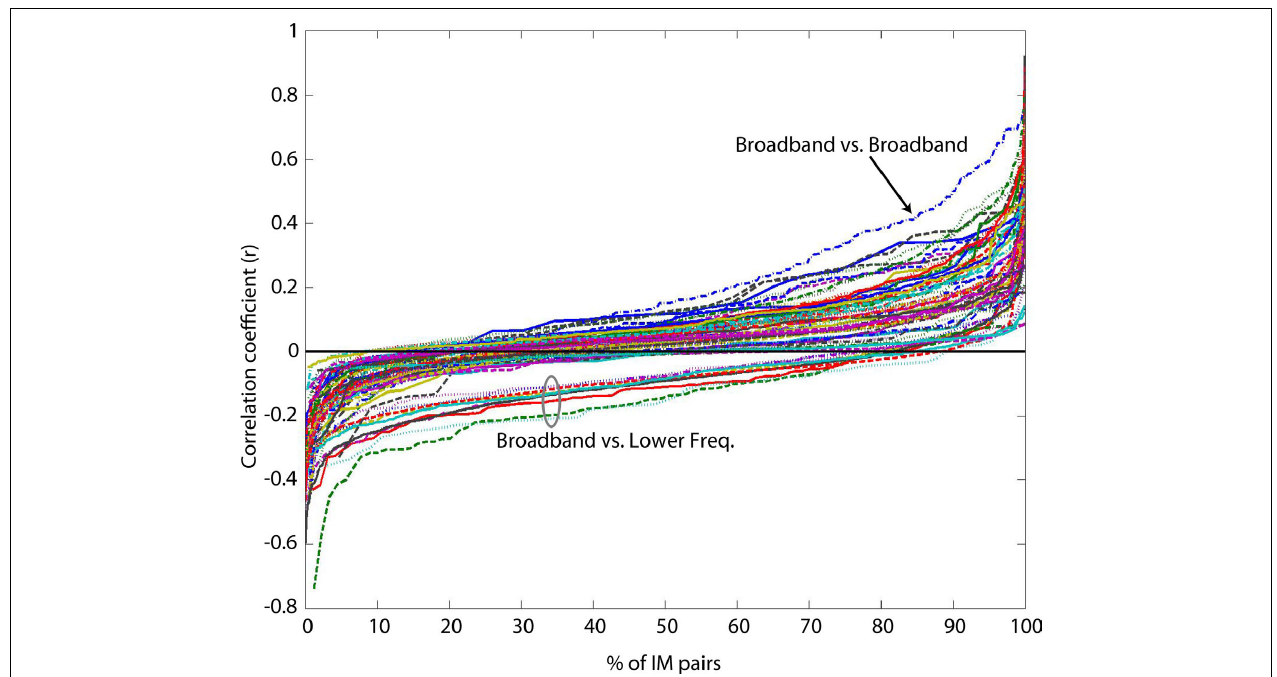
FIGURE 6 | Value-sorted time course correlations of all within-subject IM pairs for each pair of IM clusters. Traces represent sorted correlation coeffi cients between time weights from pair-wise comparisons of 11 IM clusters, each point representing a within-subject correlation of two IM time courses over 14 emotion imagination periods (excepting ‘compassion,’ see main text). IM clusters affected spectral changes in Delta, low Theta1, high Theta2, below-peak Alpha1, at-peak Alpha2, above-peak Alpha3, low to high